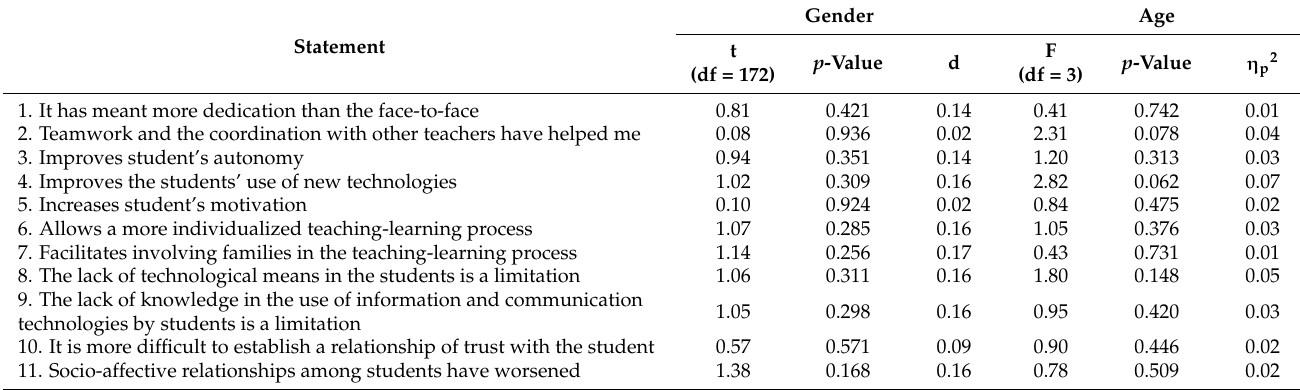
Table 2. Differences by teacher gender and age for the study